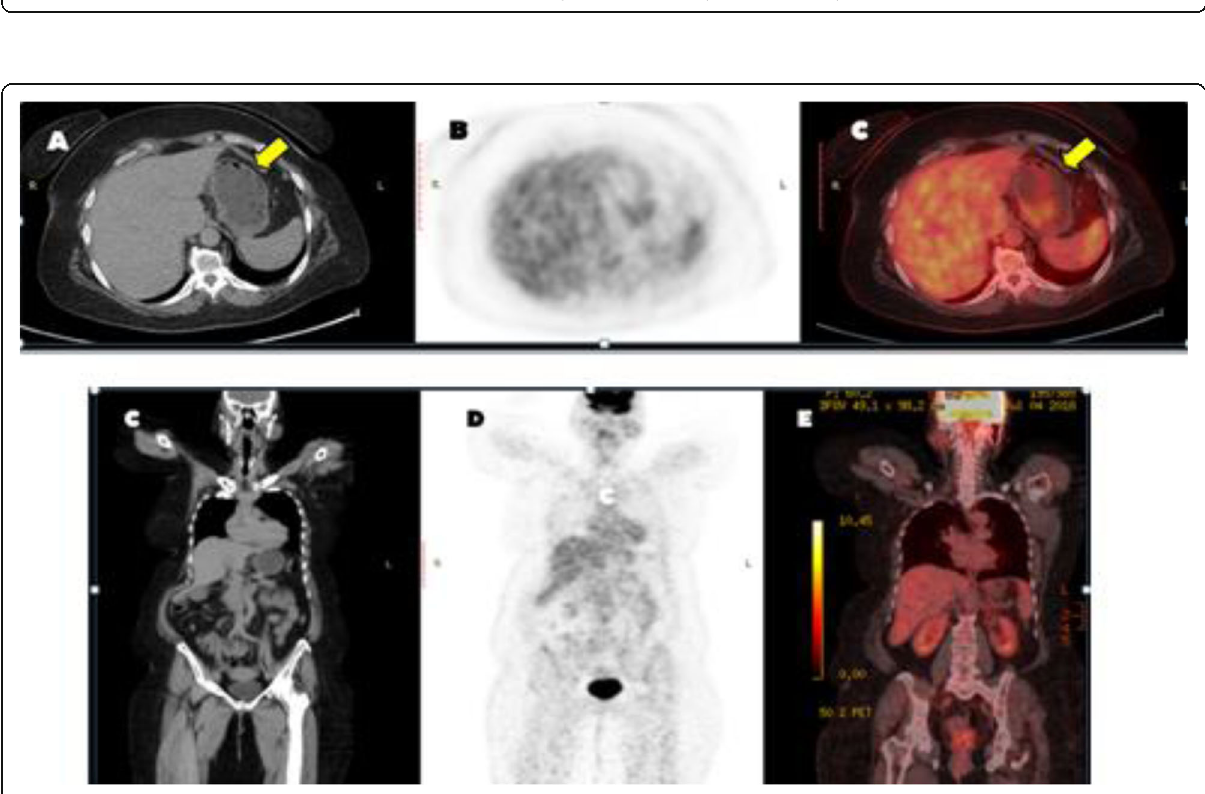
Fig. 4 Axial post-contrast CT, PET, and fused PET/CT images for a 50-year-old male patient with gastric antrum adenocarcinoma and had received chemotherapy . Images a – c showed an ill-defined gastric antrum metabolically active lesion (red arrows) merging with metabolically active omental soft tissue sheet (blue arrows) with SUVmax ~ 13.8. Images d – f showed multiple metabolically active peritoneal nodular lesions (blue arrows) with SUVmax ~ 17.8; moreover, a moderate to marked low grade metabolically active ascites (yellow arrows) was seen